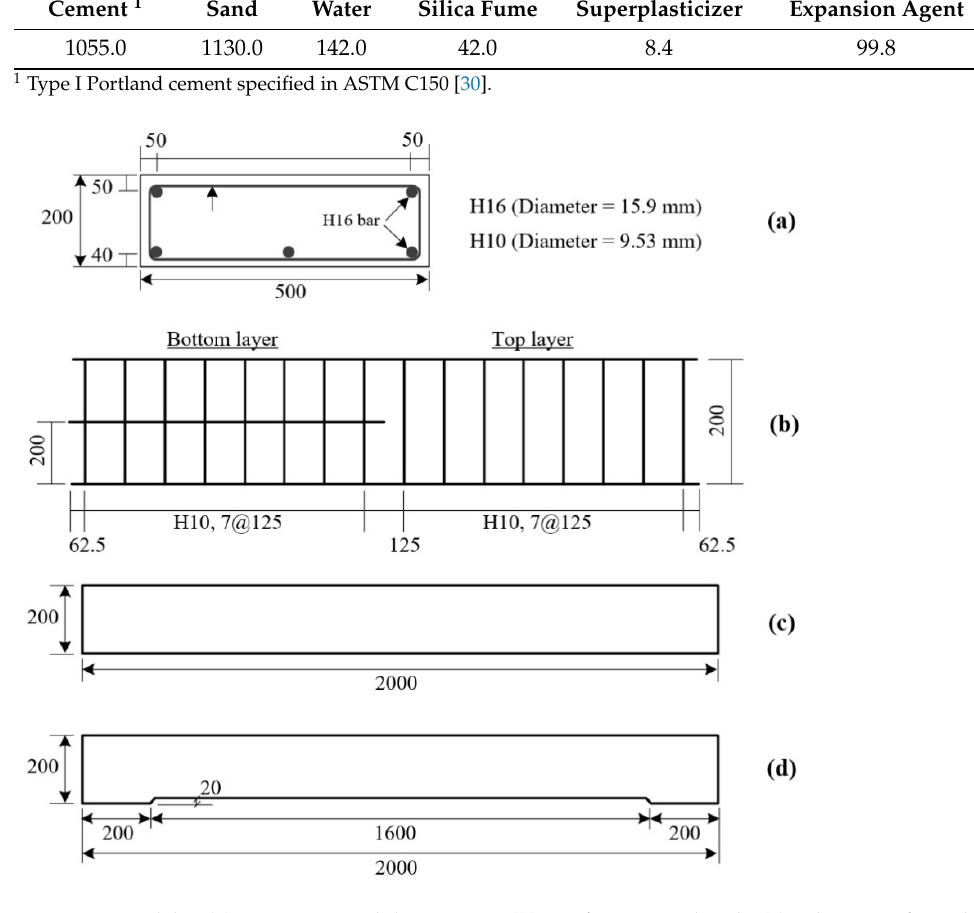
Figure 3. RC slabs: ( a ) cross ‐ sectional dimensions; ( b ) reinforcement details; ( c ) side view of RC slab; and ( d ) side view of RC slab with indented space (unit: mm). Table 1. Mix composition of ready ‐ mixed concrete (unit: kg/m 3 ).